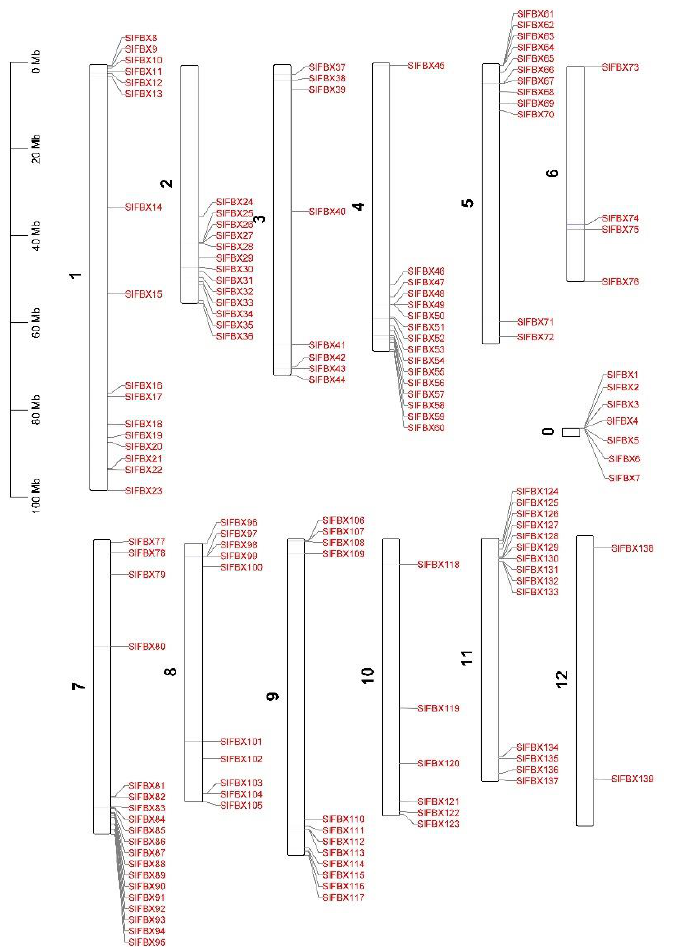
Figure 4. Chromosomal locations of SlFBX genes in tomato, 1 to 12 is the tomato’s 12 chromosomes, with 0 representing the location of genes not located on the chromosome.